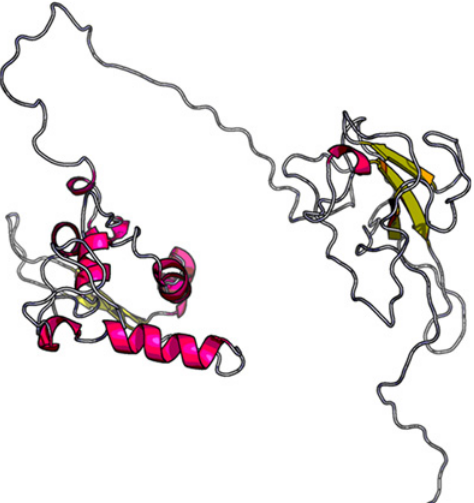
Fig 2. A 3D model of the highest antigenic nucleocapsid (N) protein of MERS-CoV that were modeled by using RaptorX web server.